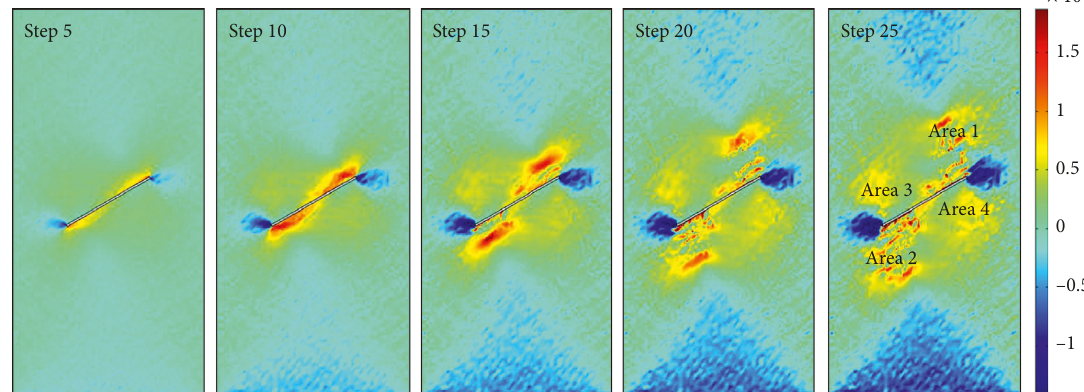
Figure 12: Stress distribution of the sample with preexisting fracture ( α